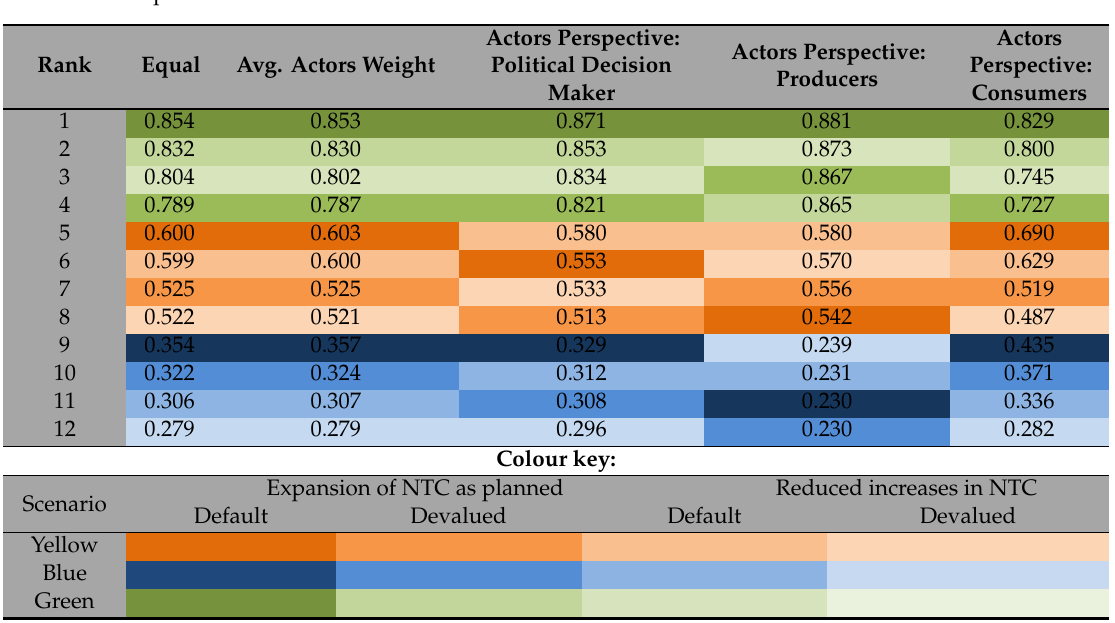
Table A3. TOPSIS analysis of modeling results with 35% reduction of NTC expansion. Source: Own